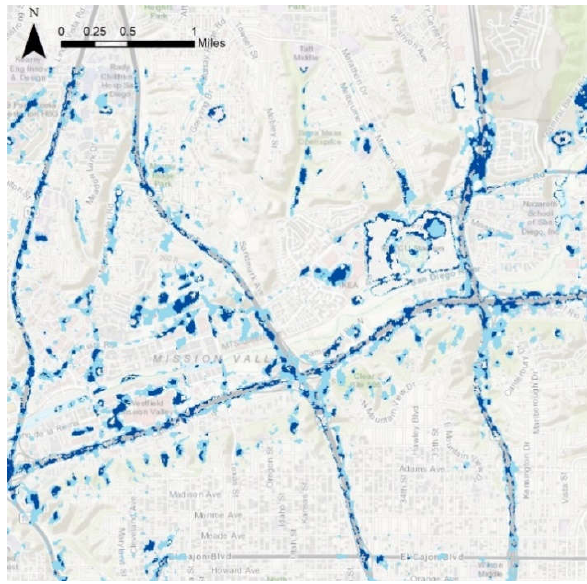
Figure 10. Mission Valley Submap.